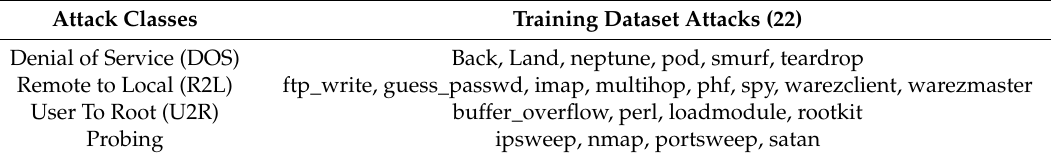
Table 3. KDD ’99 attack